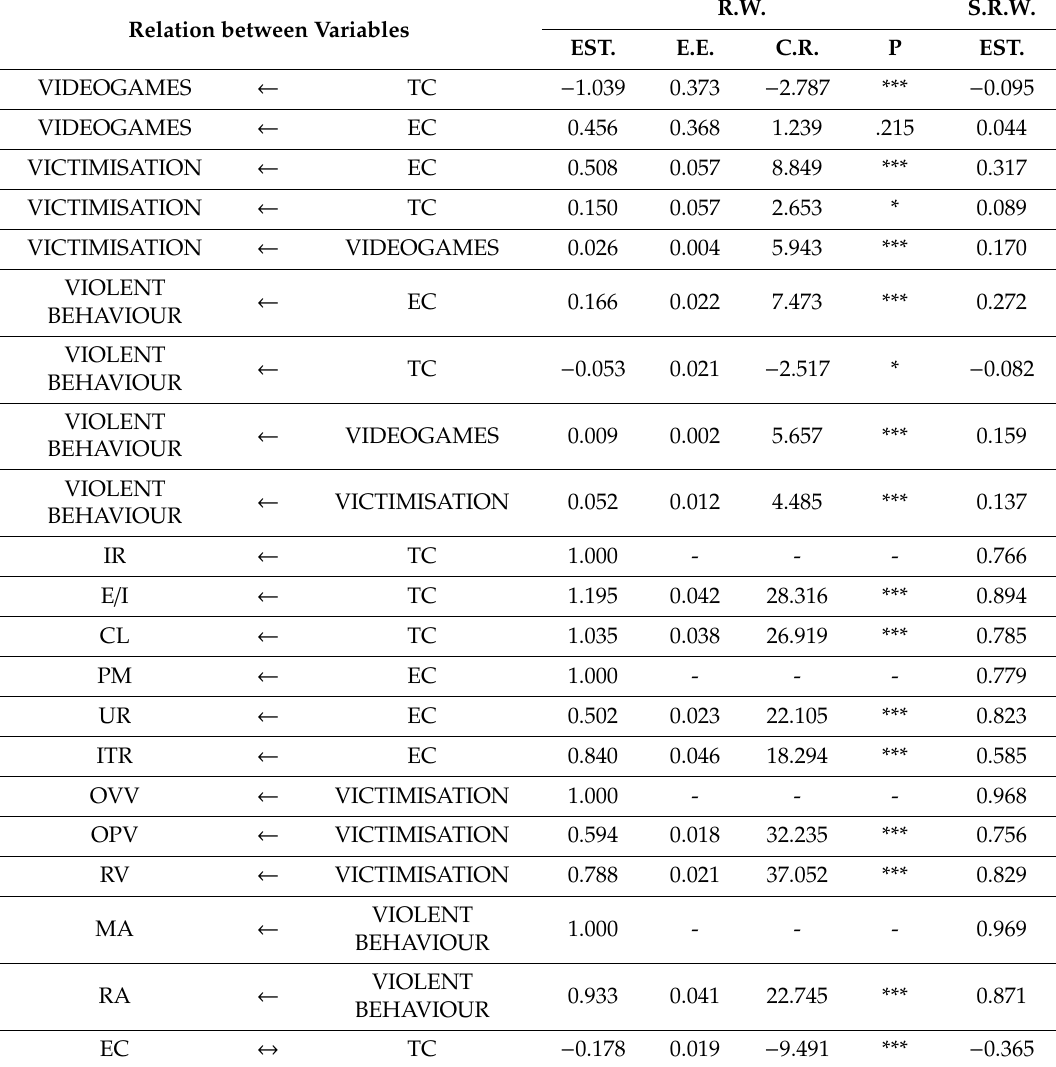
Table 1. Structural model for physical